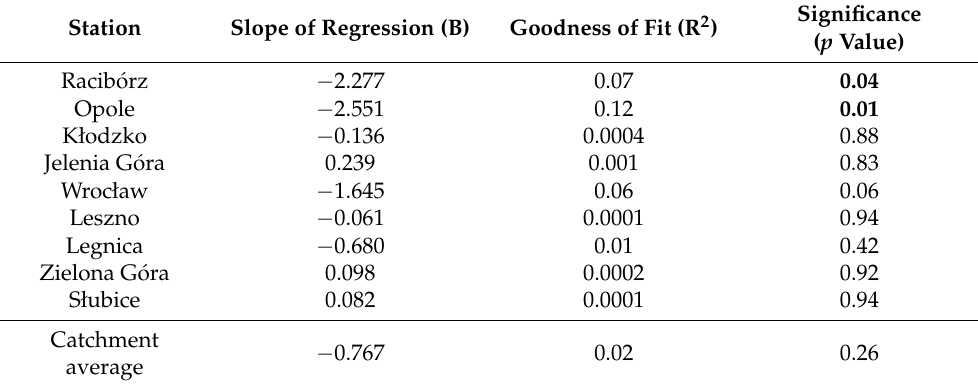
Table 1. Results from linear regression analysis for the relationships between annual precipitation totals recorded at 9 stations from the upper and middle parts of the Odra River catchment as well as catchment-average annual precipitation, and calendar years. p -values < 0.05 are indicated in bold. Station Slope of Regression (B) Goodness of Fit (R 2 )